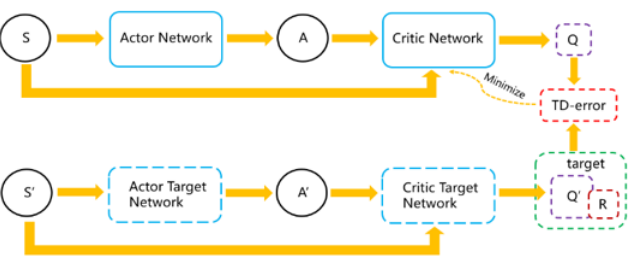
Figure 2. DDPG algorithm flowchart.